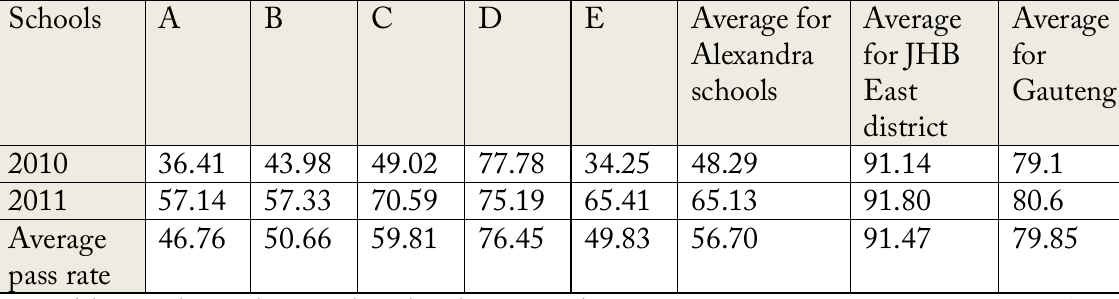
Table 1: Alexandra High School matriculation pass rates (source: GDE,